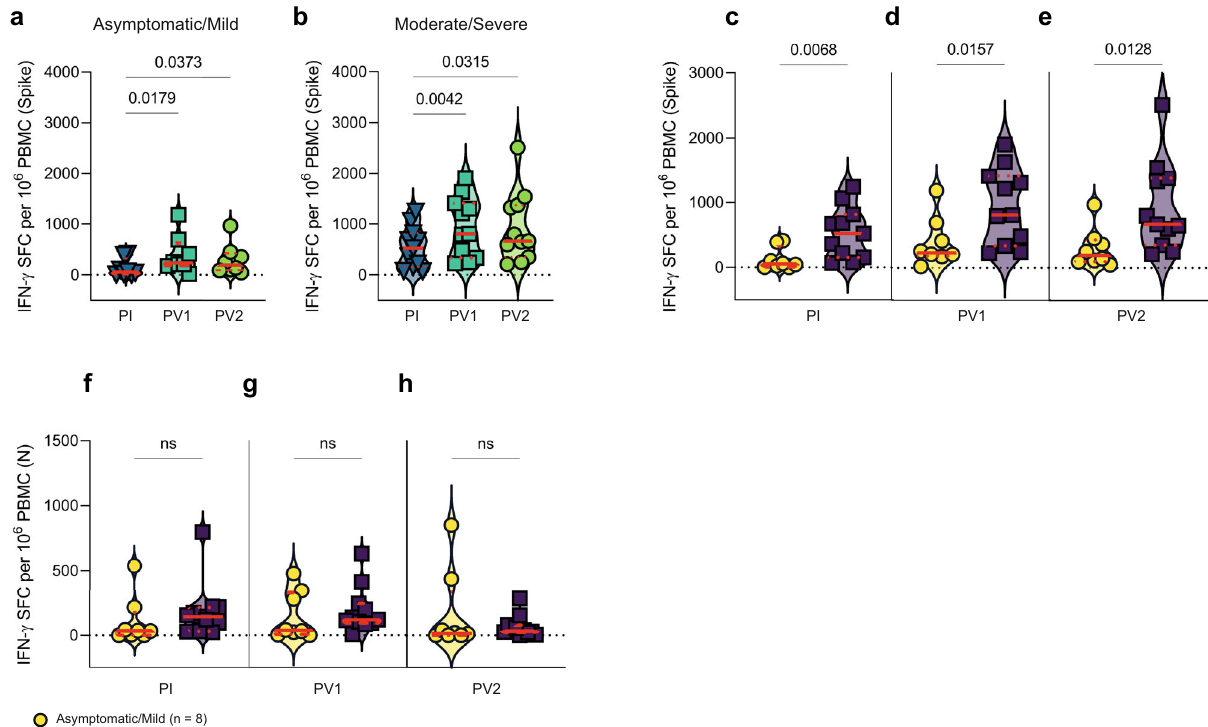
Fig. 5 Enumeration and comparison of circulating SARS-CoV-2 S- and N-speci fi c T cells following infection, primary vaccination and secondary vaccination. After 24 h stimulation with S or N peptides, antigen-speci fi c circulating T cells were detected as IFN- γ spot forming cells (SFC). Results from sequential samples obtained after infection, PV1 and PV2 were expressed as SFC/million PBMC and shown for a asymptomatic/mild ( n = 8) and b moderate/severe ( n = 11) groups. P values in a and b were calculated using Friedman ’ s test with Dunn ’ s multiple comparisons test and signi fi cance is shown above lines spanning the groups compared. Comparisons of IFN- γ SFC/million PBMC after S stimulation between the two groups are shown c after infection, d PV1, and e PV2. Comparisons of N-speci fi c IFN- γ SFC/million PBMC are depicted for samples taken f after infection, g PV1 and h PV2. P values in c – h were calculated using the Mann – Whitney U -test. Red lines bisecting groups represent median (solid) with IQR